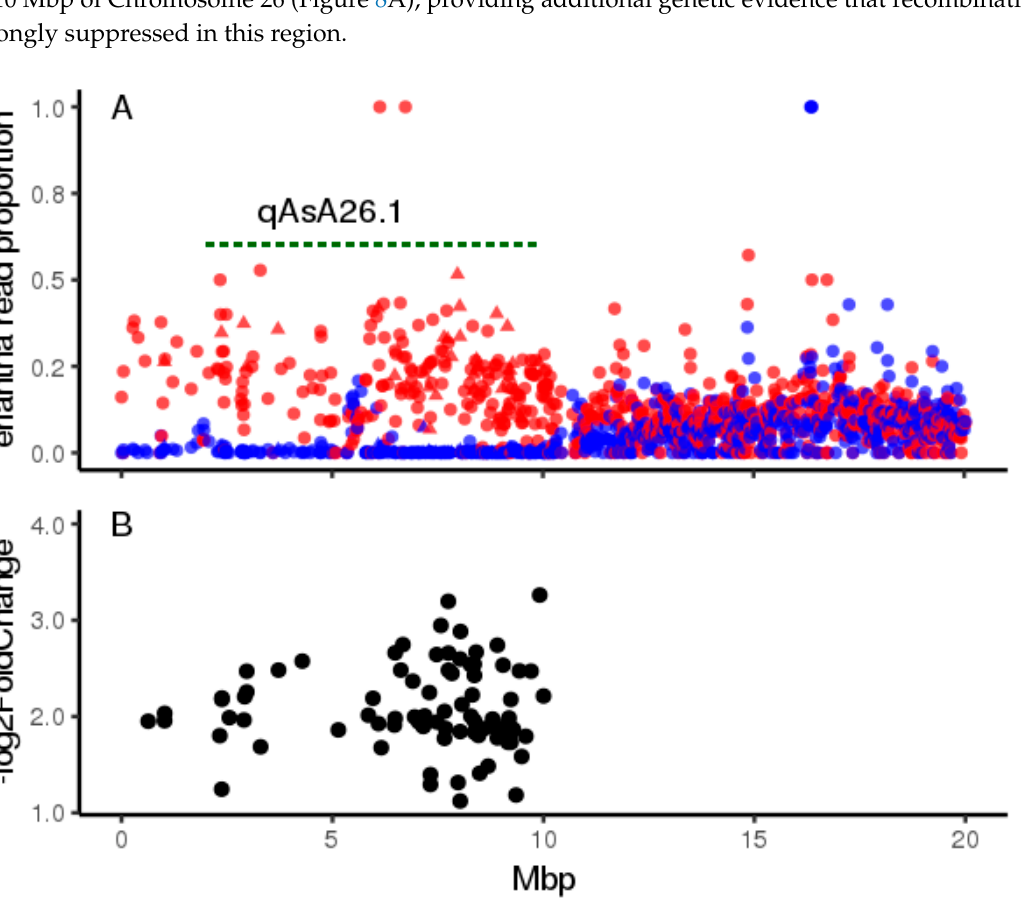
Figure 8. RNASEQ analysis of gene expression on Actinidia Chromosome 26. Points denote gene models on the A. chinensis ‘Red5’ assembly. ( A ) Allelic expression proportion based on PolyCat read assignment. Red and blue symbols denote high and low AsA pools, respectively. Triangular points denote gene models with transcripts exhibiting di ff erential expression. ( B ) Genomic coordinates and Log2Fold expression di ff erences of transcripts showing significant di ff erential